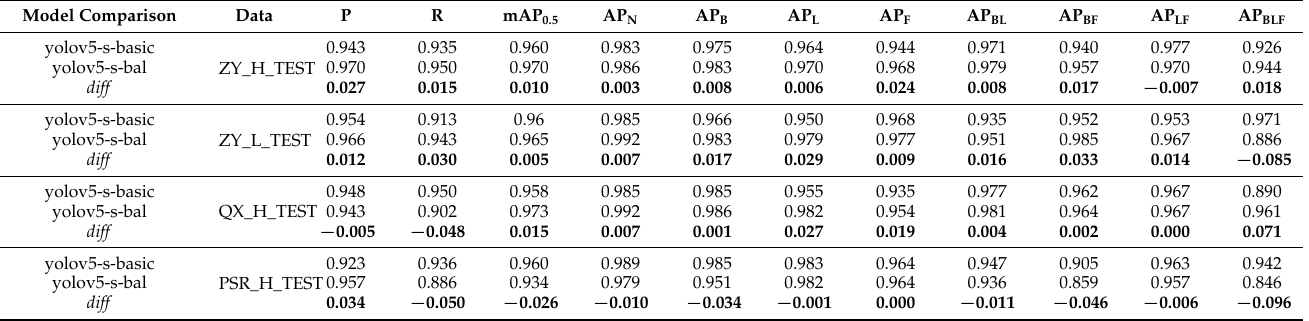
Table 6. Comparison of the statistical results of yolov5-s-basic and yolov5-s-bal for all metrics in test dataset.